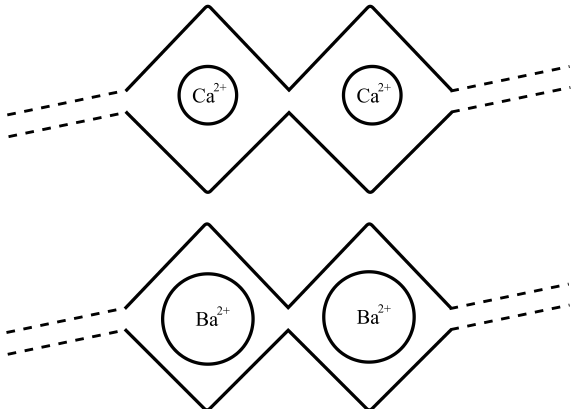
Figure 6. Egg-box model that illustrates the sizes of Ca 2+ and Ba 2+ ions that formed an ionic coordina- tion with